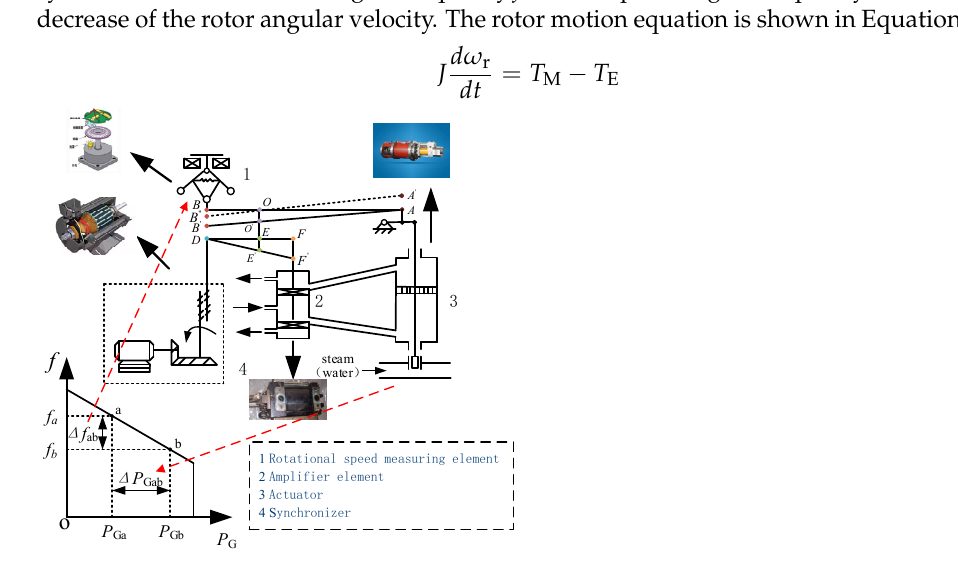
Figure A1. Droop mechanism analysis of a synchronous set.